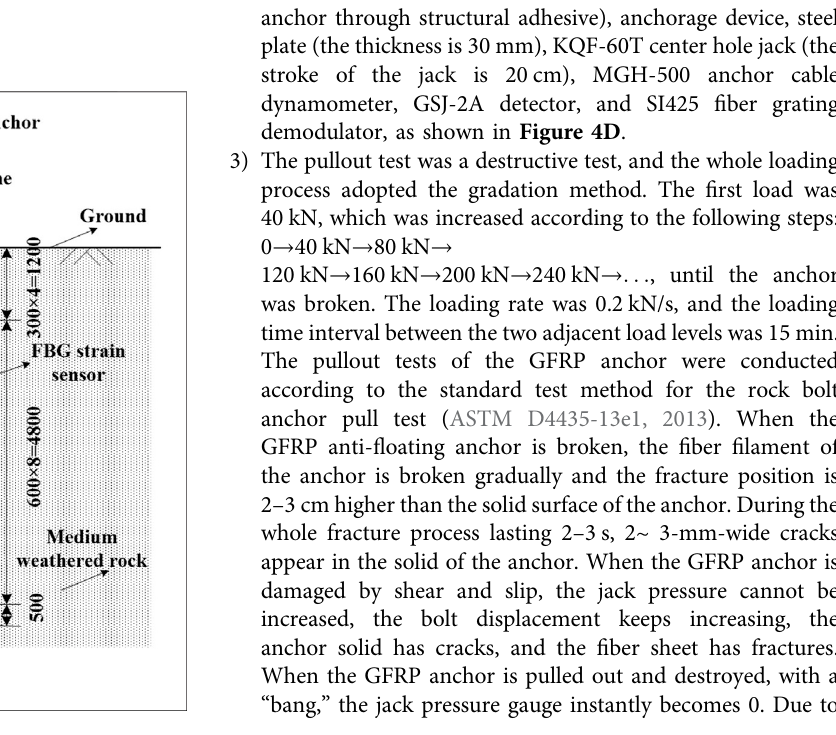
Frontiers in Materials |